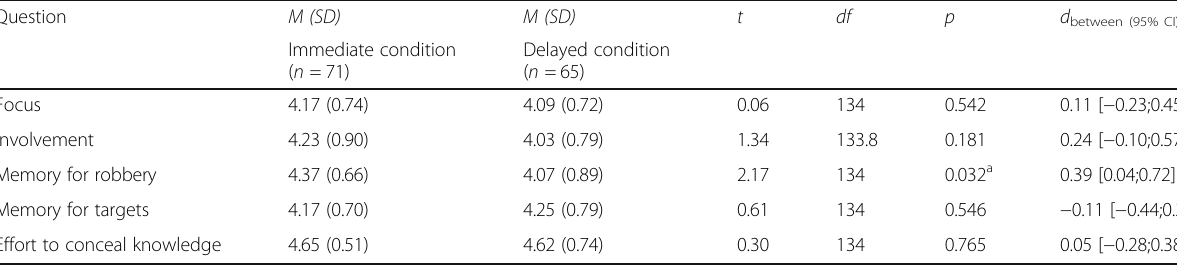
Table 2 Mean scores on the follow-up questionnaire (5-point Likert scale) Question M